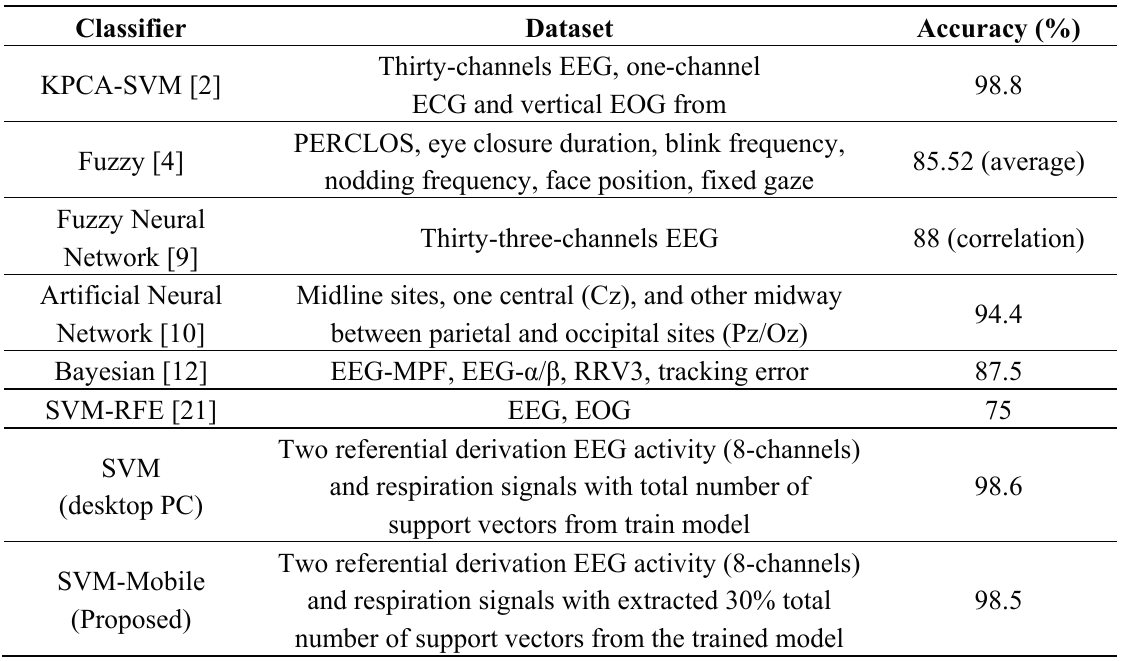
Table 5. Comparison of classifiers in predicting the driver’s vigilance